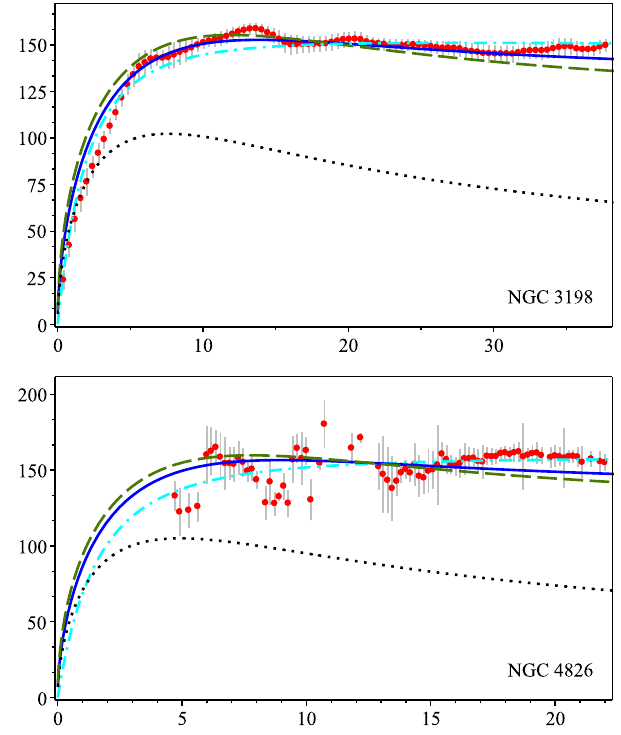
Figure 3. (color online) Comparison of rotation curves obtained using the “core” mass distribution (7) ( cyan dash-dot curve ), the observed data ( red full circles with vertical grey lines (error bars)), the disk profile (21) ( green dash curve ) and the “core-disk” mass distribution ( blue solid curve ) together with its Newtonian contribution ( black dotted curve